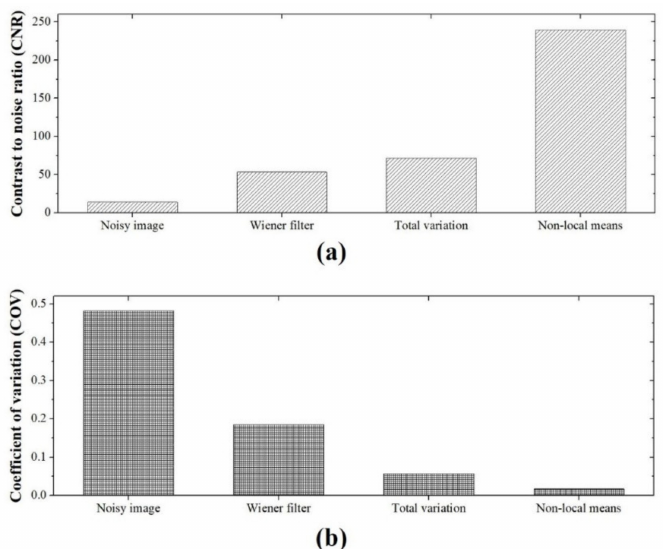
Figure 8. Experimental results for the ( a ) contrast-to-noise ratio (using ROI 1 and ROI 2 in Figure 7) and ( b ) coe ffi cient of variation (using ROI 1 in Figure 7) as a function of the denoising method using the image of the concrete dummy